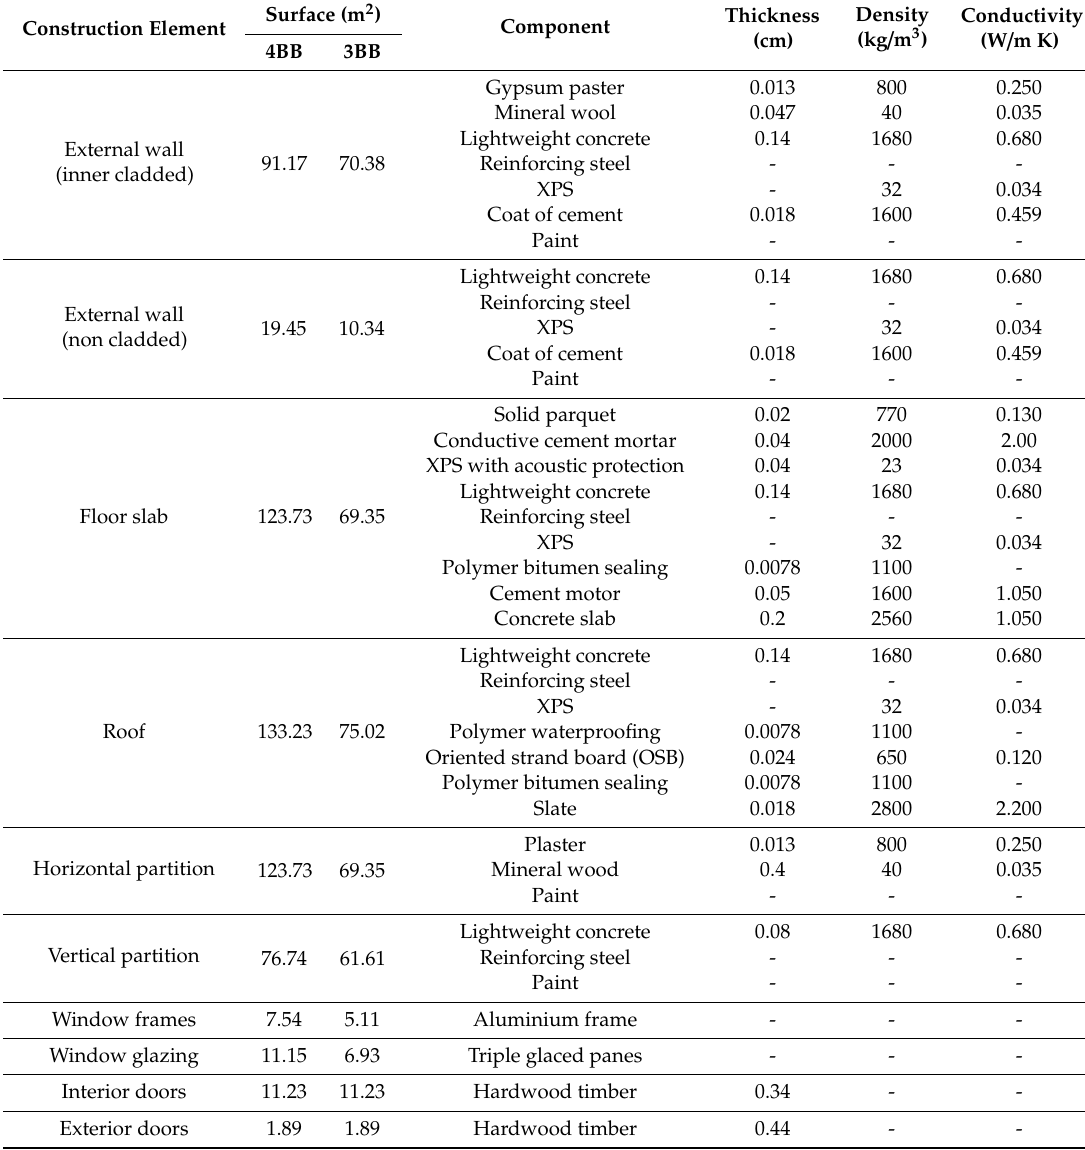
Table 3. Characteristics of the construction elements of the houses without additional expanded polystyrene (XPS)